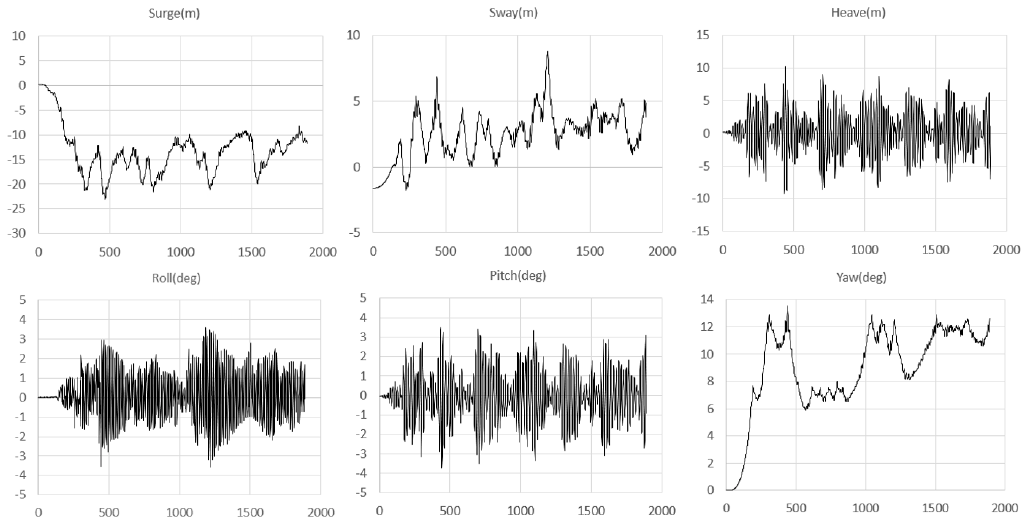
Figure 15. DP FPSO-Controlled Motion using the Penalty Programming. Figure 15 . DP FPSO-Controlled Motion using the Penalty Programming. Figure 15 . DP FPSO-Controlled Motion using the Penalty Programming.